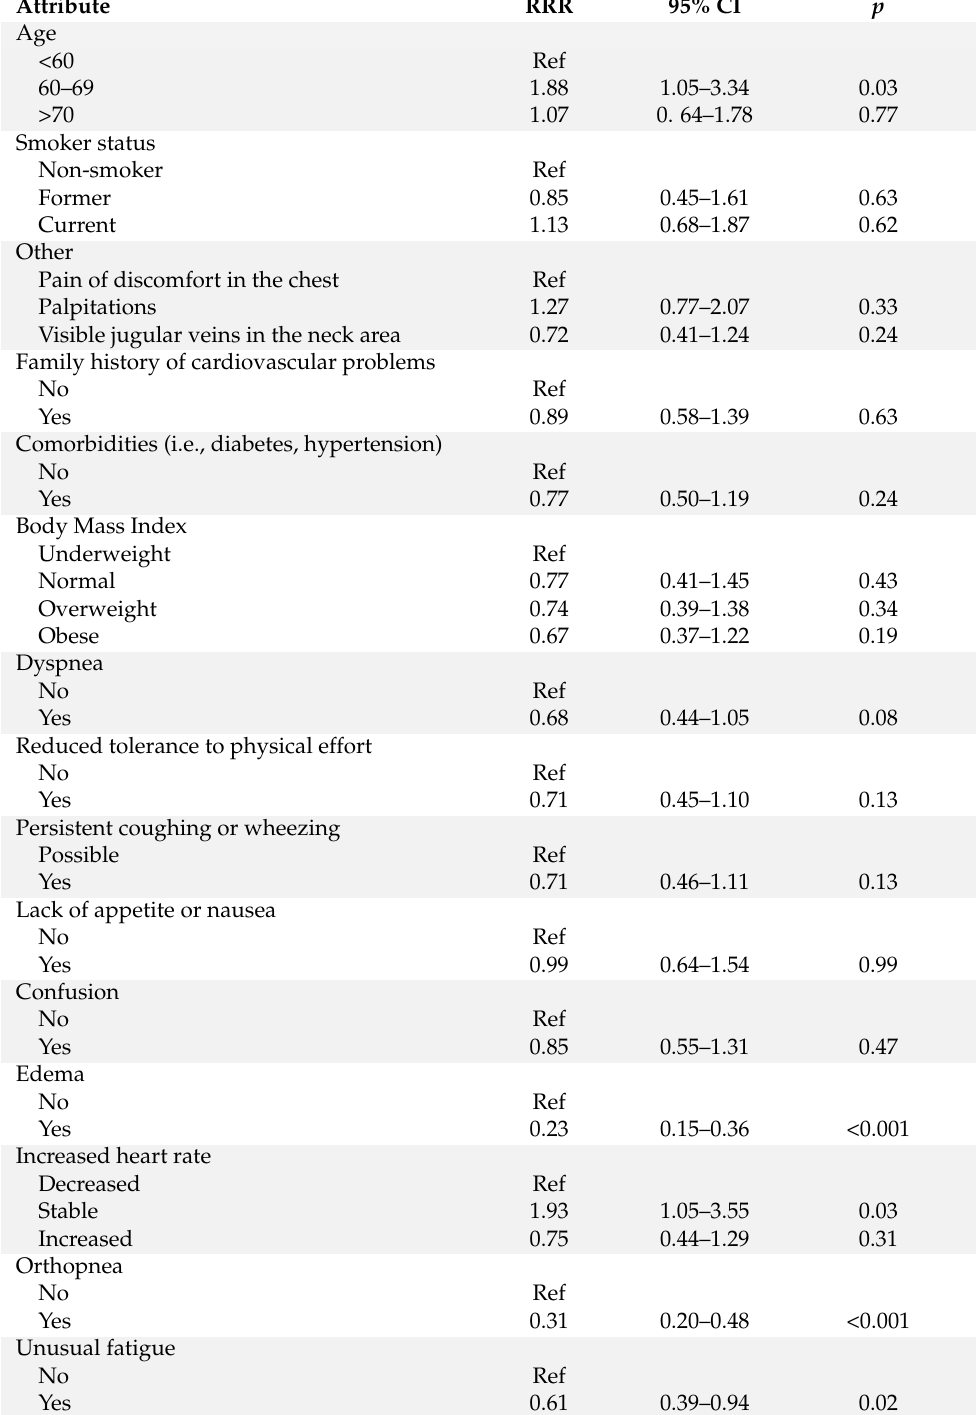
Abbreviations: RRR, relative risk